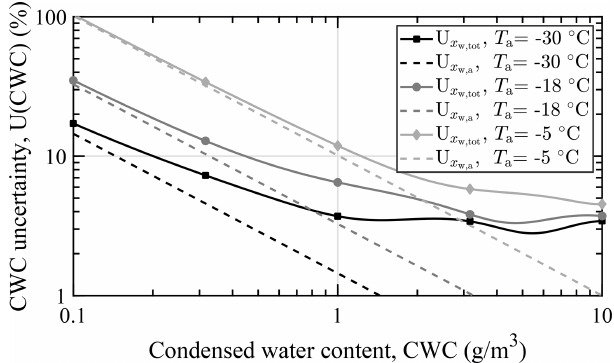
Figure 9. Hygrometer measurement uncertainty contributions to the 95% CWC measurement uncertainty at three static air tem- peratures, an airspeed of 60ms − 1 , and a static air pressure of 1013 . 25hPa. Condensed water content uncertainty contributions are given relative to the actual CWC and for isokinetic sampling. The ambient air is assumed to be fully saturated with respect to su- percooled